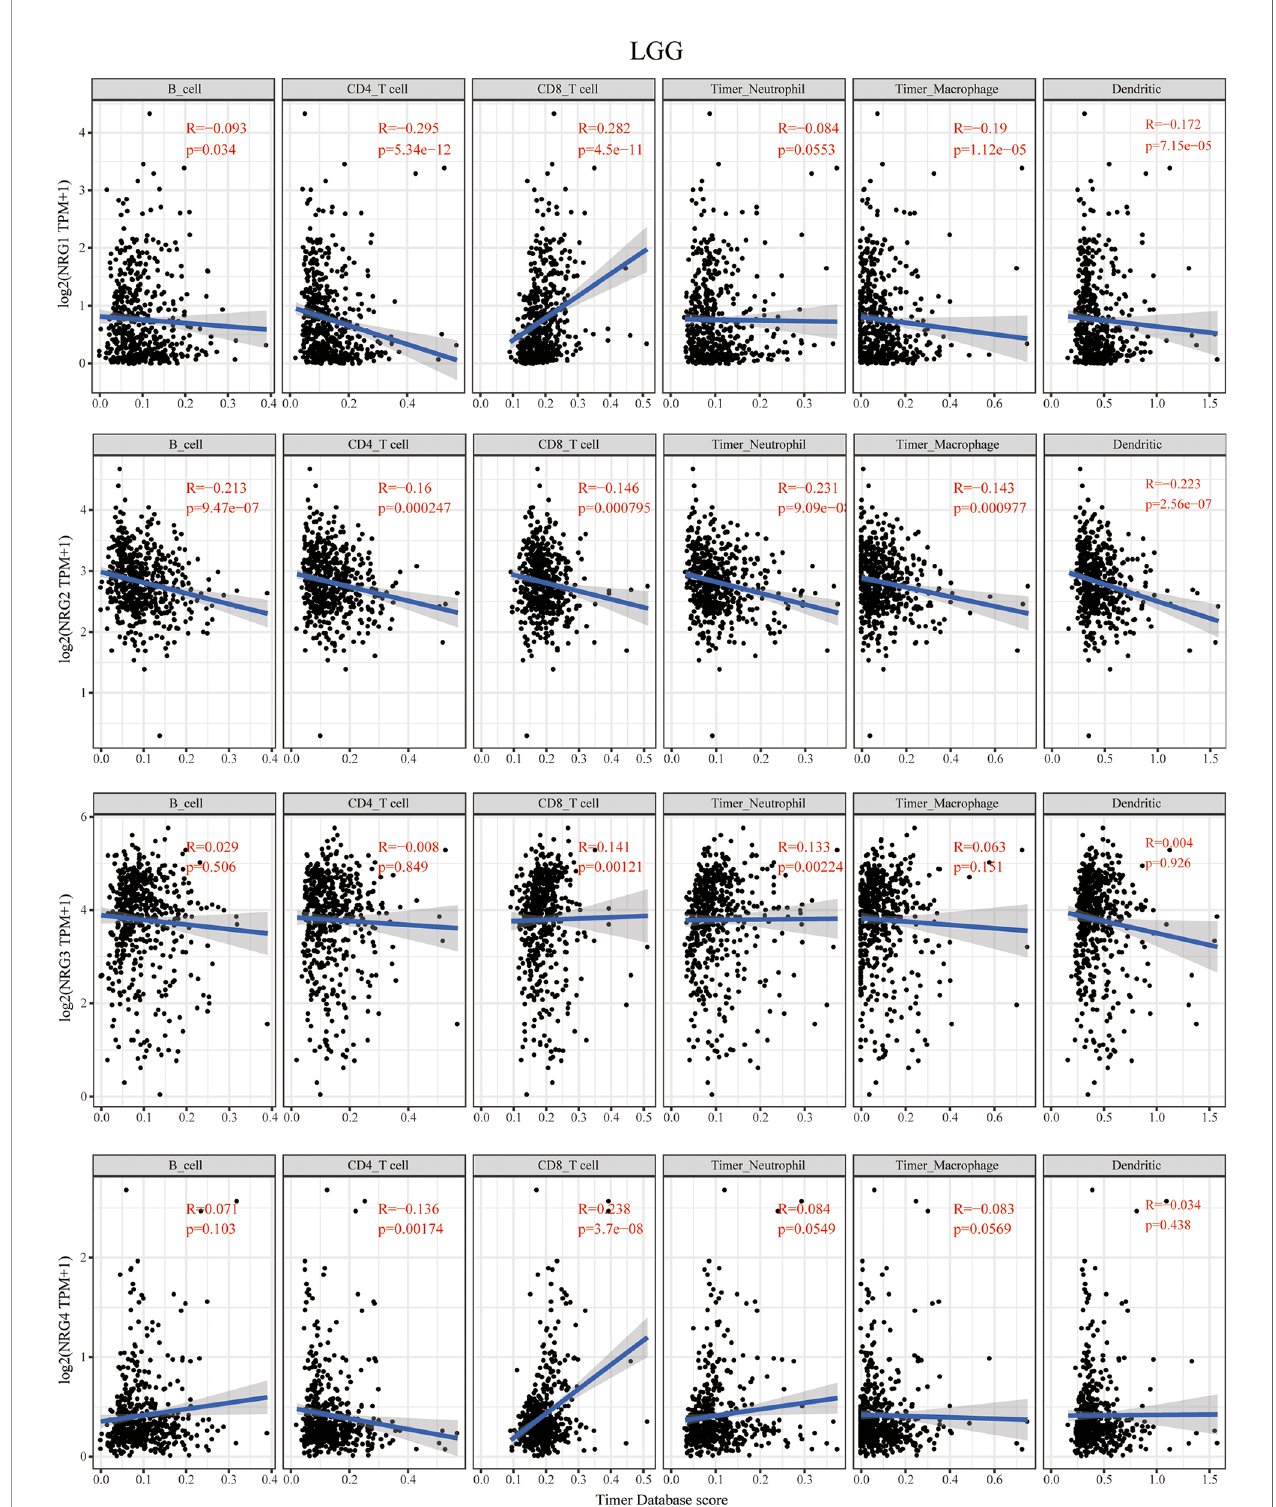
FIGURE 3 | Correlations between NRGs expression and immune cell in fi ltration in LGG. Correlations between the abundance of 6 immune cells (B cell, CD4 T cell, CD8 T cell, neutrophils, macrophage and dendritic cell) from TIMER database and the expression of NRG1-4 in LGG. Spearman ’ s correlation analysis was used to describe the correlation. P < 0.05 was considered statistically signi fi